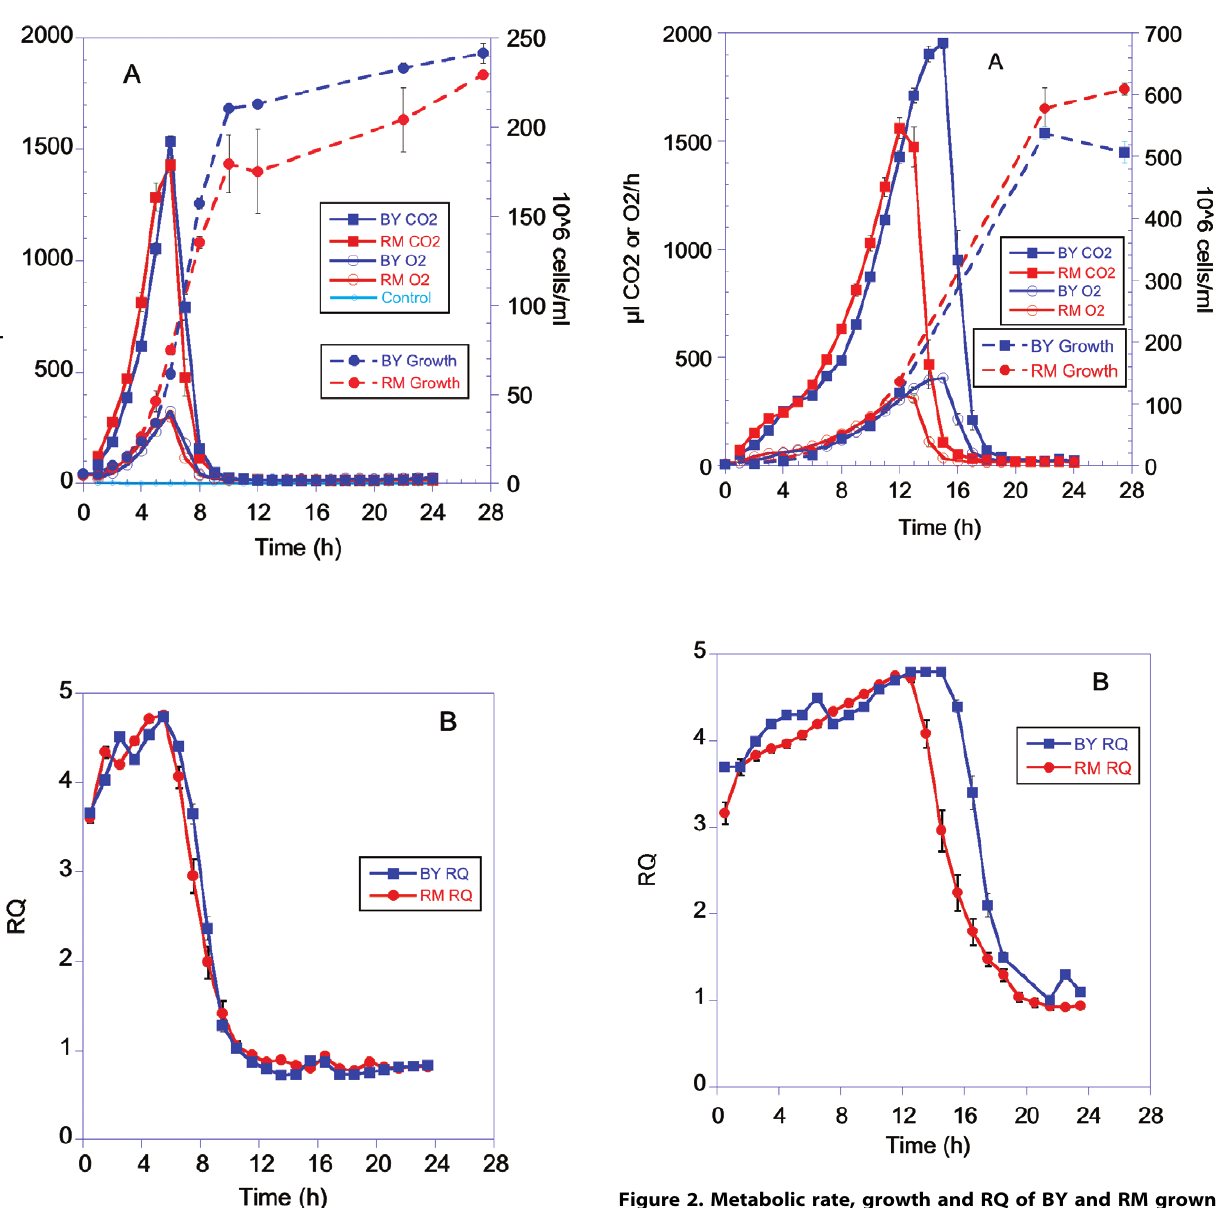
Figure 2. Metabolic rate, growth and RQ of BY and RM grown in YP with 3% galactose. Graphs are plotted using the means and sem of 6 groups for the CO 2 /O 2 measurements and for 3 groups for the growth